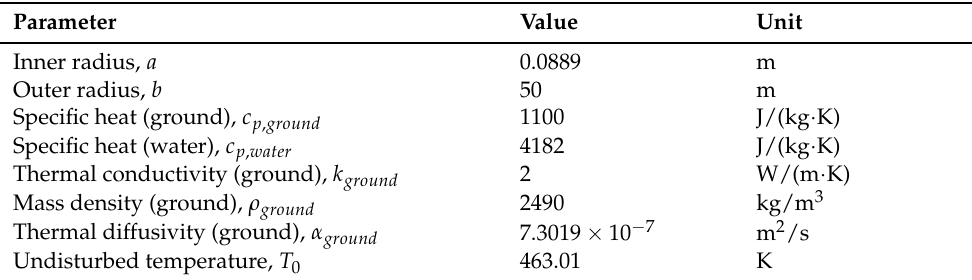
Table 2. Prescribed geometrical and thermophysical parameters of the ground and working fluid (water). The listed values of parameters are consistent with the work [40].